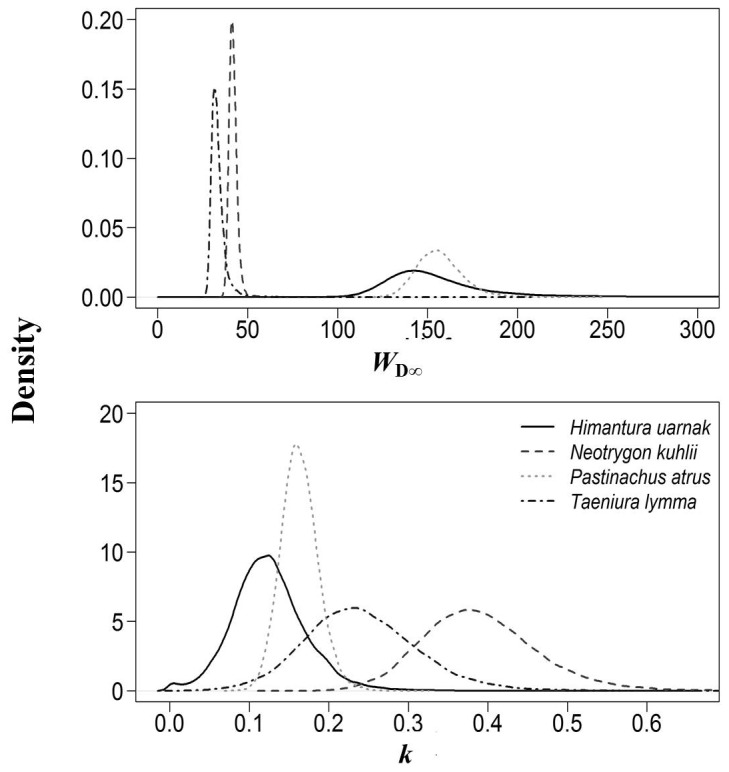
Posterior distributions for W
D∞ and k, for the four species where band pairs could be counted.